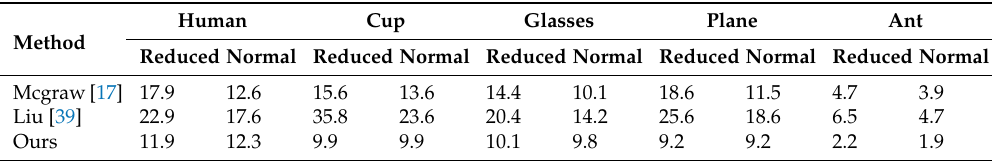
Figure 13. Comparisons on segmentation, with ( a – c ) showing the results from [17,39], and our method. Table 2. Comparisons on Segmentation (Per-category Rand Index errors of segmenting the Princeton Shape Benchmarks